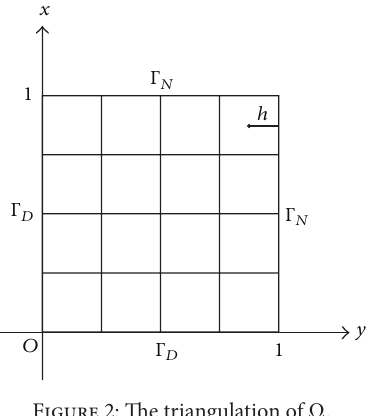
Figure 2: The triangulation of Ω